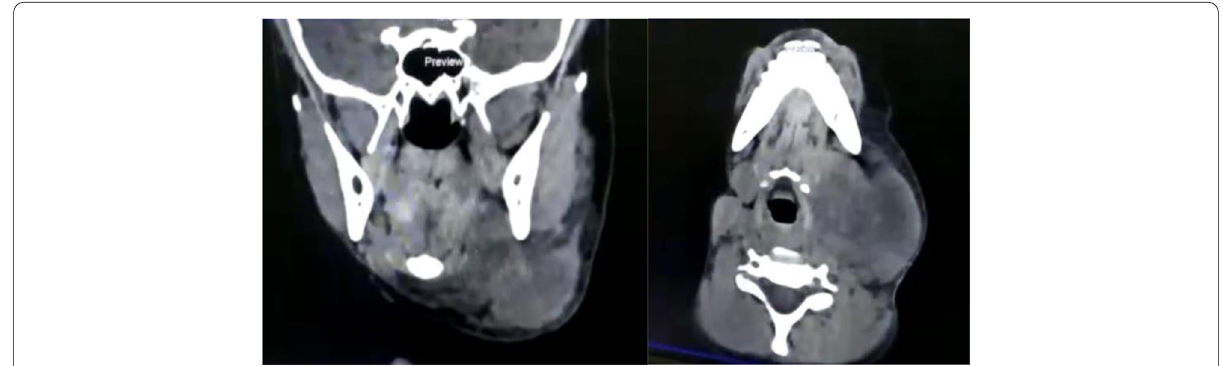
Fig. 2 Coronal and axial CT of submandibular